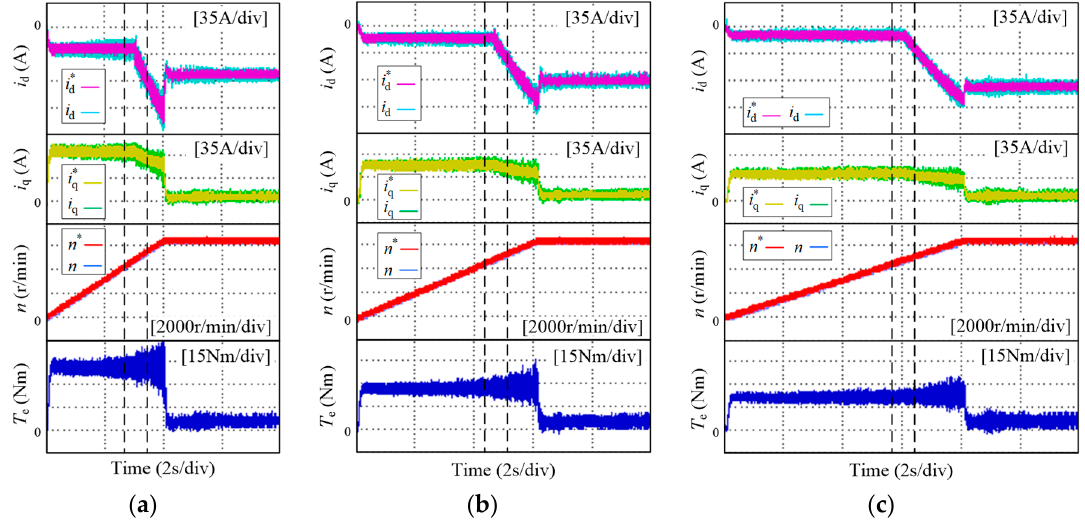
Figure 13. The flux-weakening switching waveforms under different load torque: ( a ) T L = 35 Nm; ( b ) T L = 26 Nm; ( c ) T L = 21 Nm.